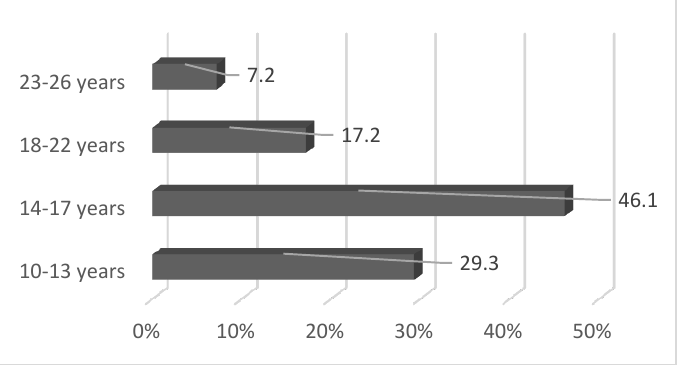
Figure 4. Age distribution of ED consumers in a Hungarian sample of 1459 subjects [131].